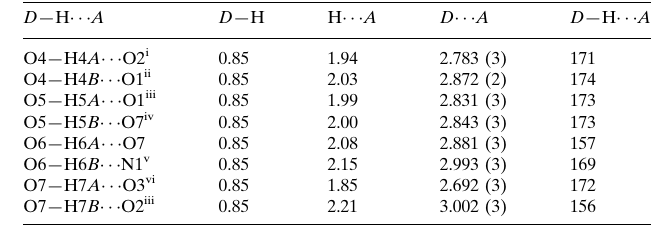
Hydrogen-bond geometry (A˚ , (cid:2)